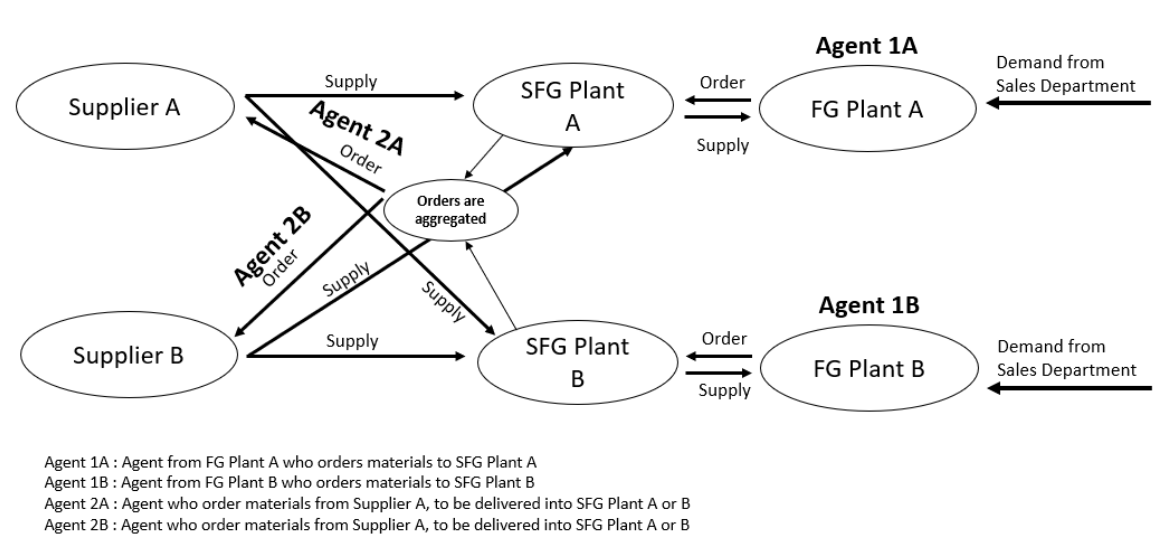
Fig. 2 Multi-echelon supply chain's